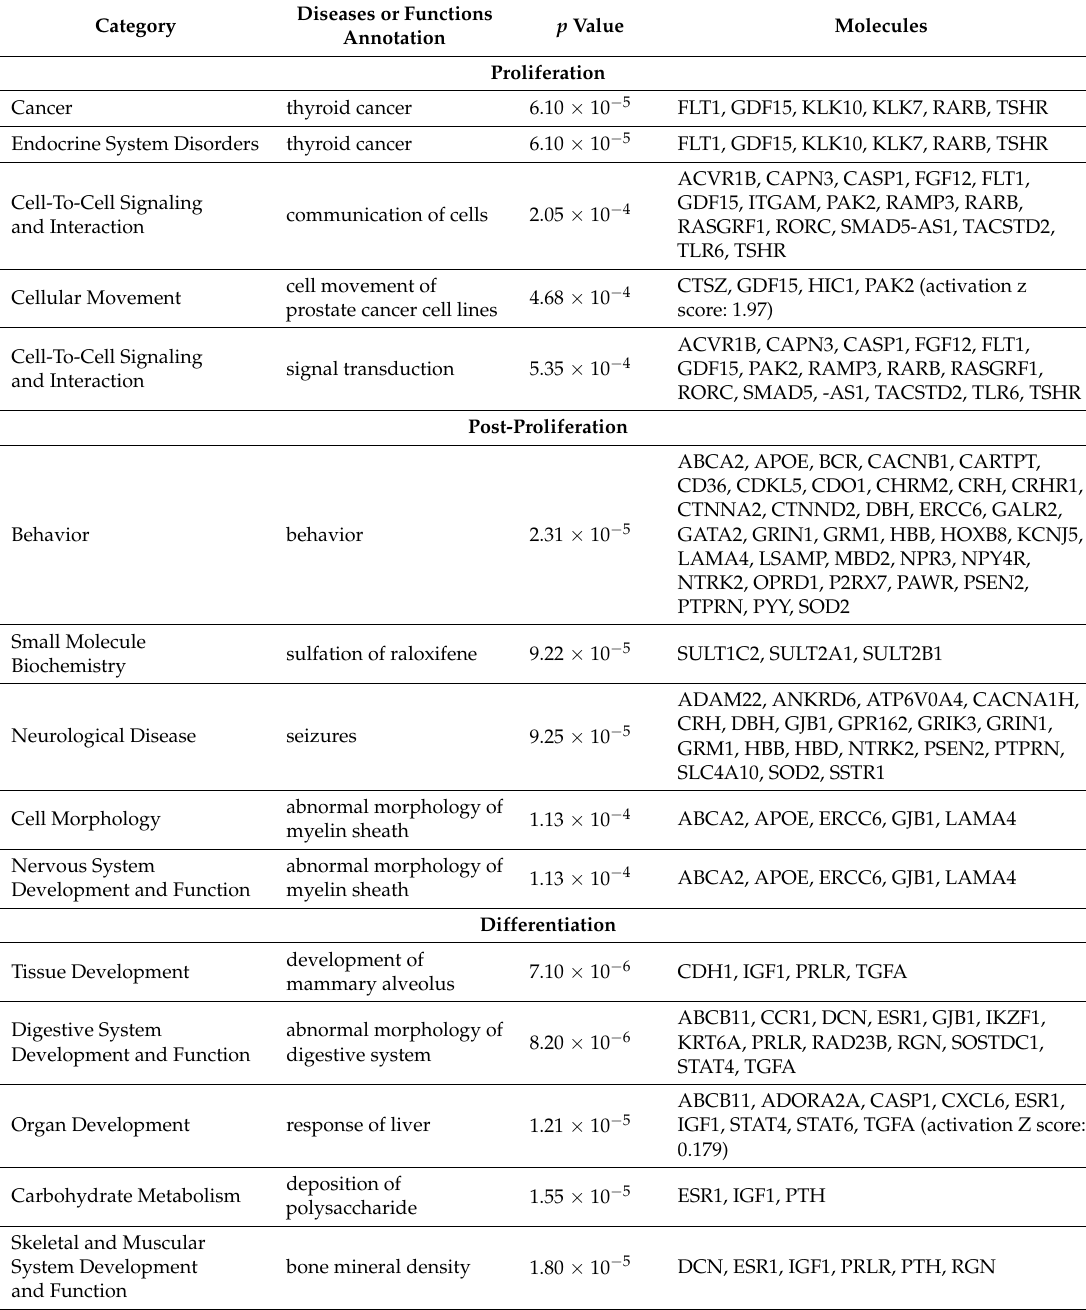
Table 2. Ingenuity pathway analysis (IPA) ranked vitamin D mediated changes in top five biofunctions (based on their p values) in 143B osteosarcoma